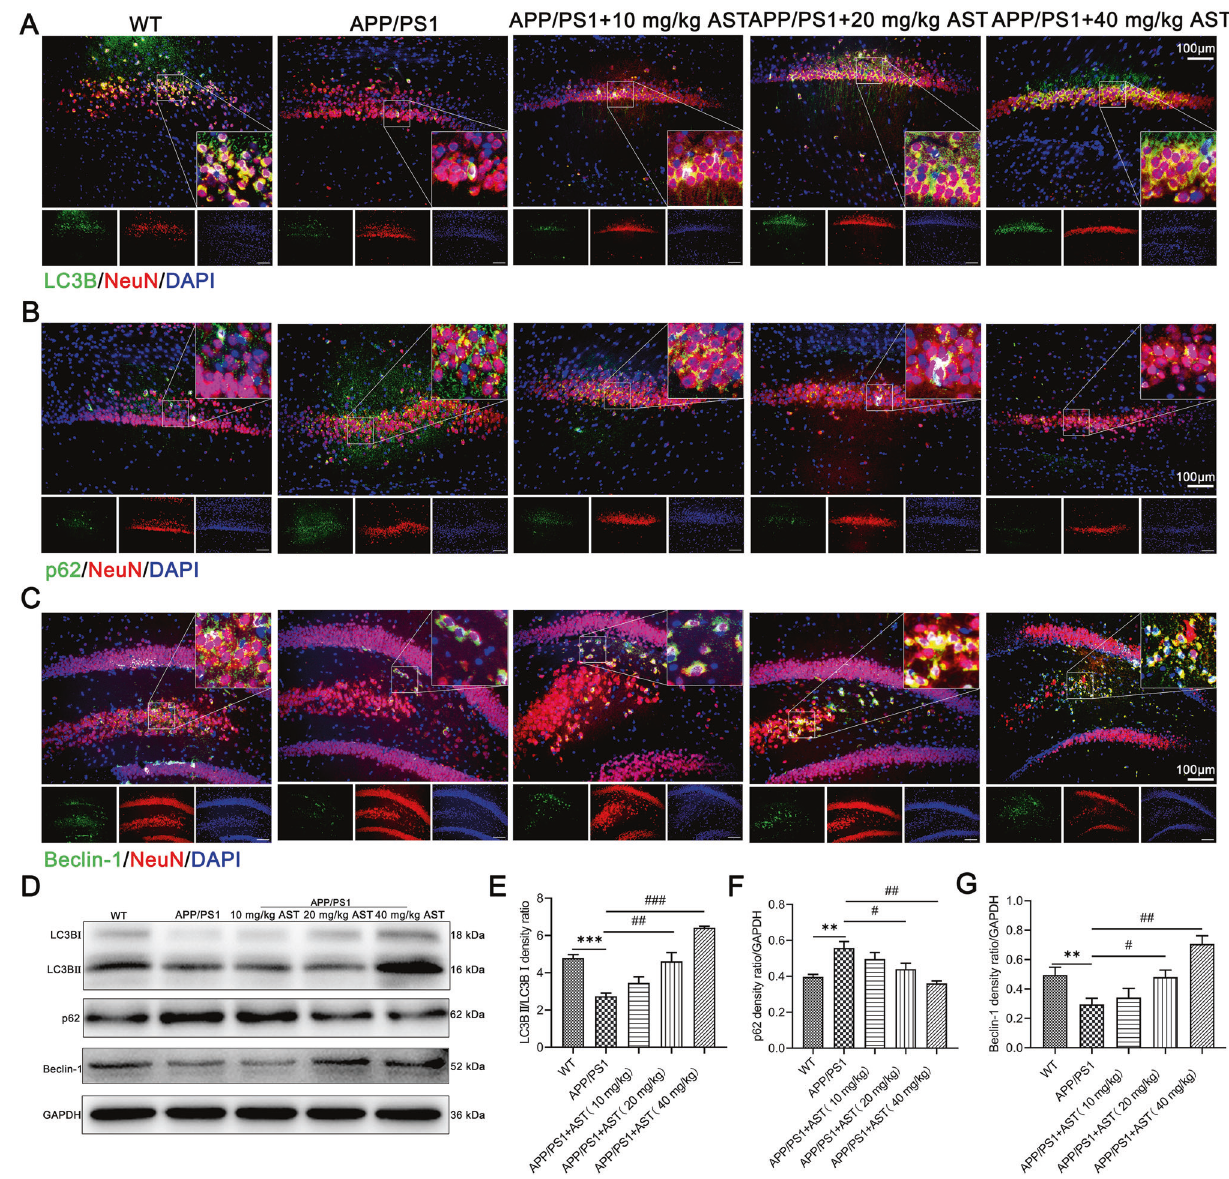
Fig. 4 AST activated autophagy initiation in hippocampal neurons of APP/PS1 mice. A – C Representative immuno fl uorescent staining of LC3B/p62/Beclin-1, NeuN, and DAPI in hippocampal neurons of mice. Scale bar = 100 μ m. D Representative bands of LC3BII/LC3BI, p62, and Beclin-1 in the hippocampus of mice by western blot (WB) detection. E – G Statistical analysis of LC3BII/LC3BI, p62, and Beclin-1 proteins in the hippocampus of mice. Data were presented as mean ± SD, n = 3/group. ** p < 0.01 and *** p < 0.001 vs WT group, # p < 0.05, ## p < 0.01 and ### p < 0.001 vs APP/PS1